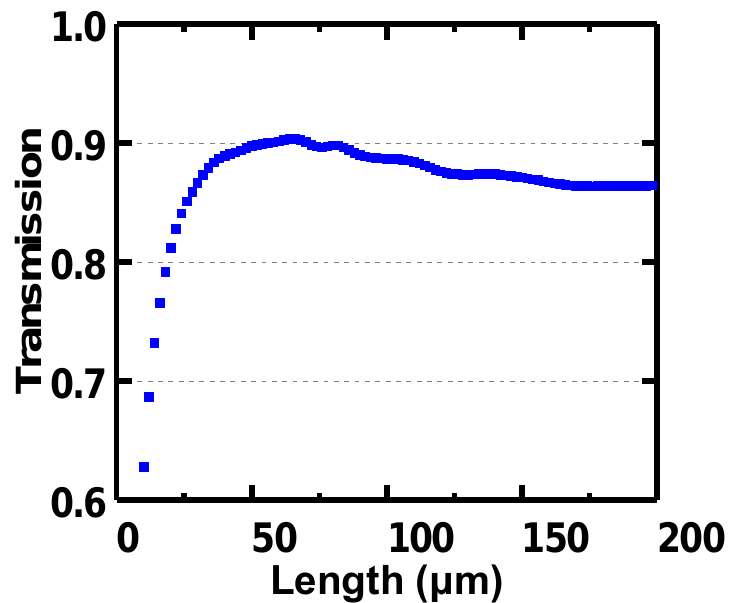
Figure 6. The edge coupler transmission to the fundamental mode as a function of Si 3 N 4 second SSC length.